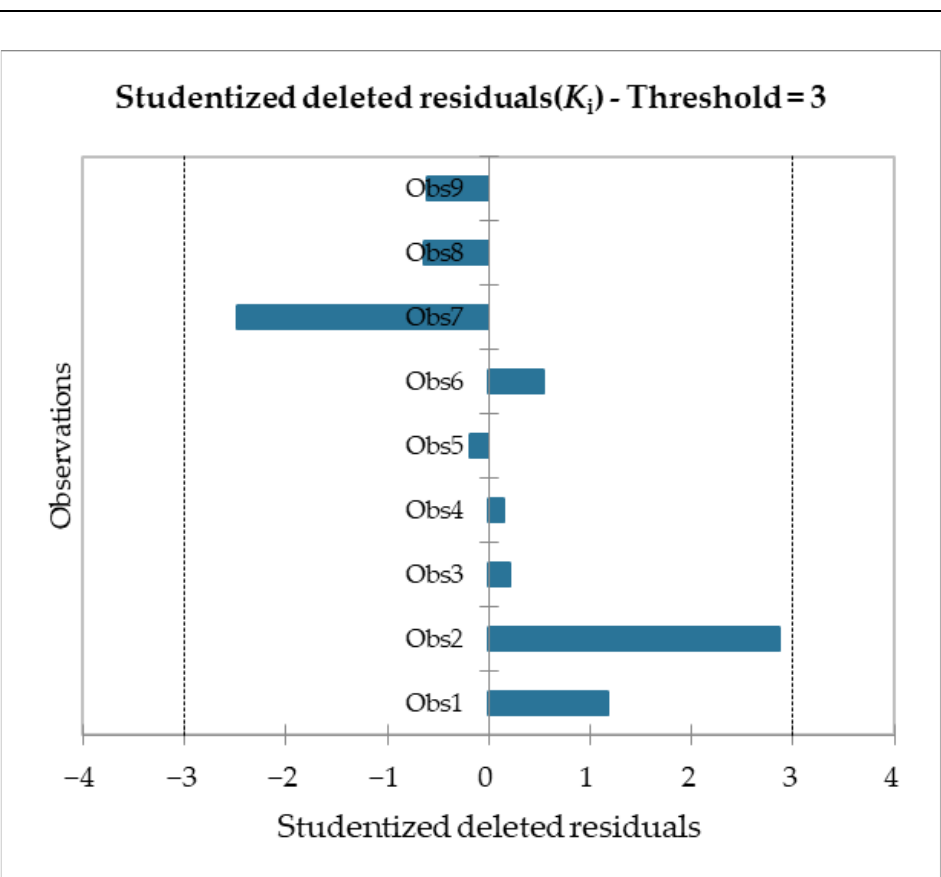
Figure 8. Studentized deleted residuals for the F max model regression.